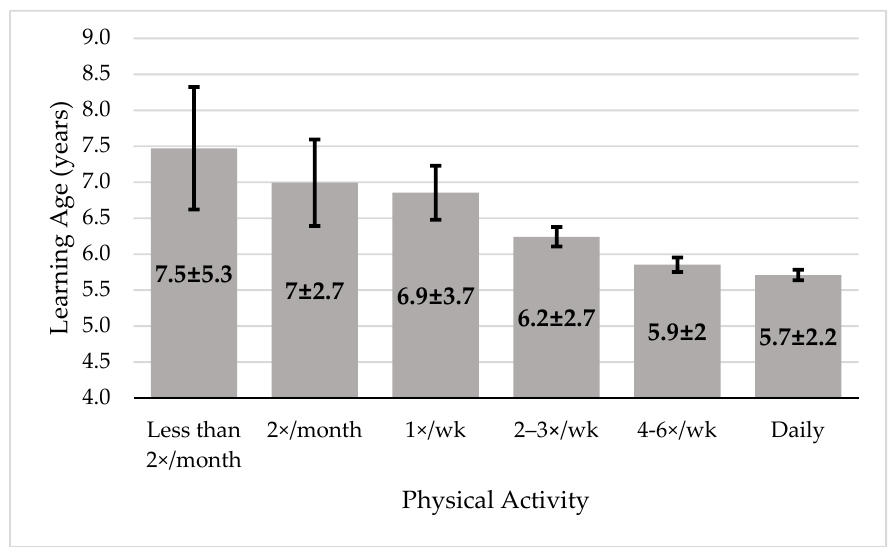
Figure 1. Mean age and standard deviation to learn how to cycle by the frequency of physical activity practice (error bars represent 95% CI).